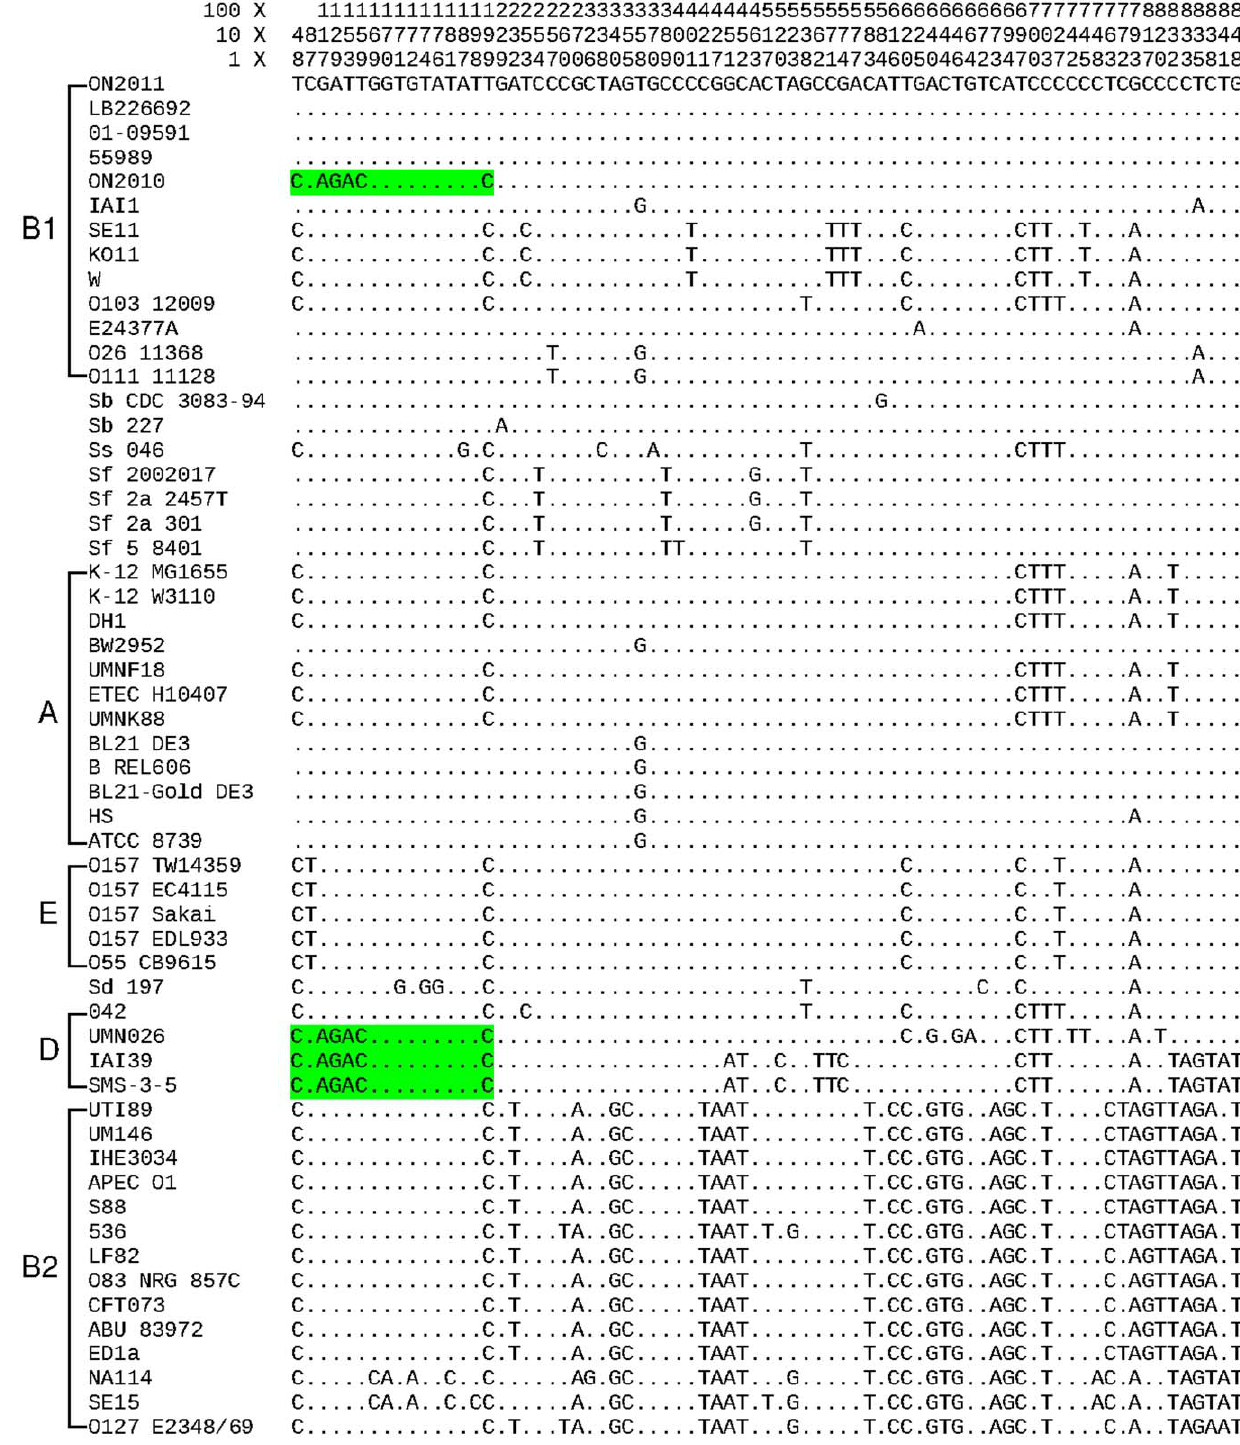
Figure 10. Sequence alignments of the araC gene. Regions that are identical with the ON2010 sequence are highlighted in light green. doi:10.1371/journal.pone.0033971.g010 genome wide change in E.coli is only 0.0225 mutations per genome per year. In contrast, we found that, in ON2010, homologous recombination altered 3.4% of the core gene set. In other words, single point mutations per se in bacterial pathogens are unlikely to play as significant a role as horizontal gene transfer. Despite the